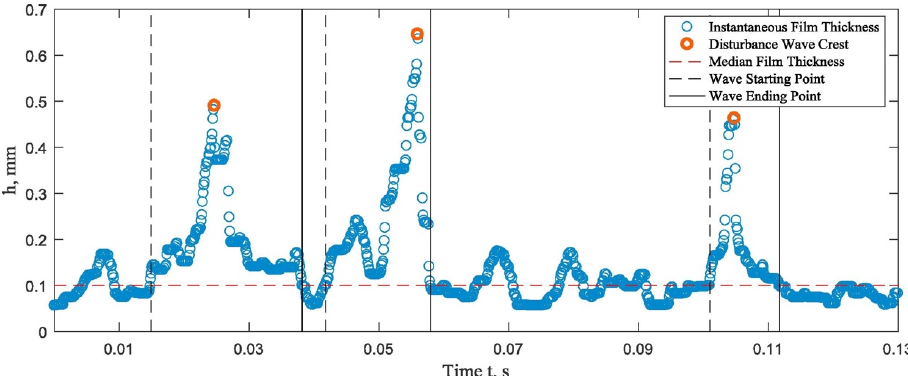
Figure 12. Film thickness distribution conducted from BBLIF [56].